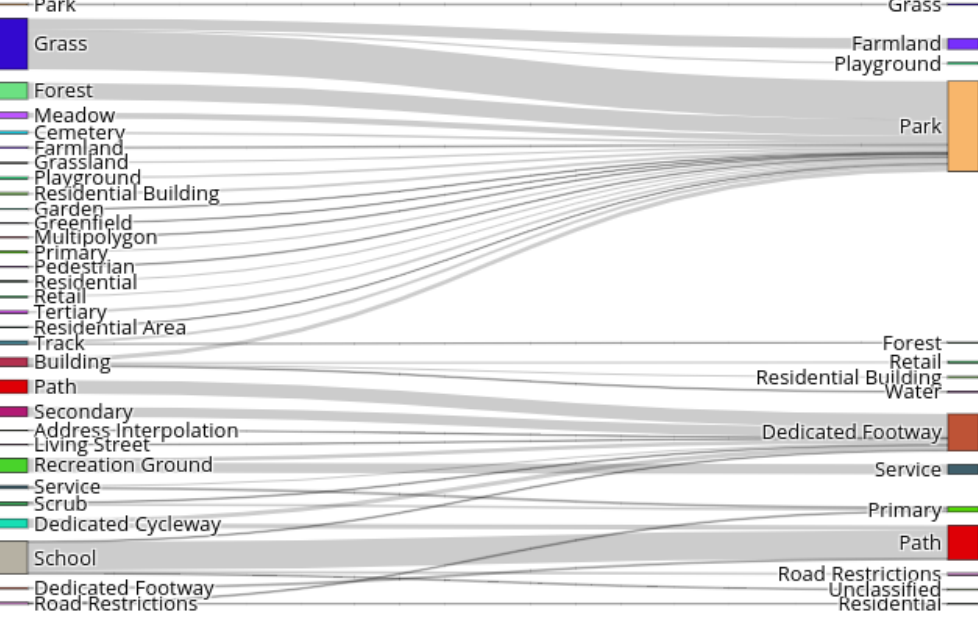
Figure 11. Changes in feature categories in PGO